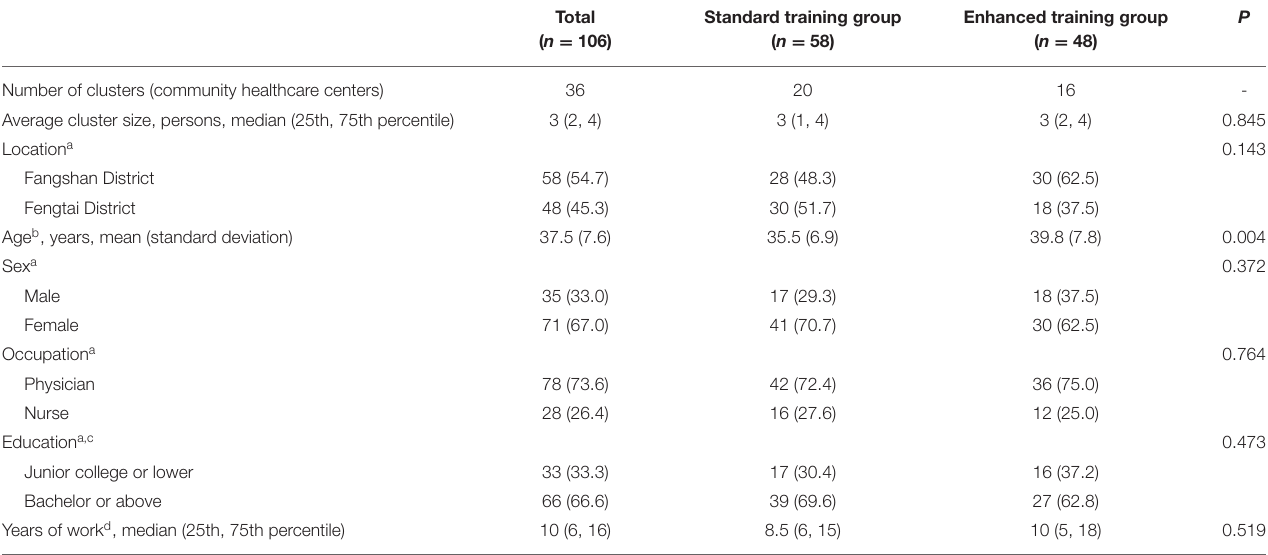
TABLE 1 | Baseline characteristics of the